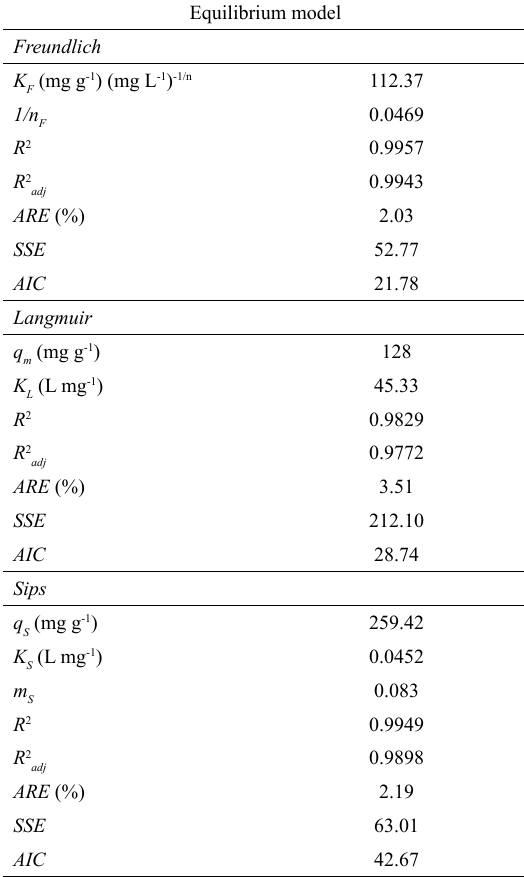
Table 3. Comparison of Brazilian natural kaolin with other low-cost adsorbents for the adsorption of MG dye.